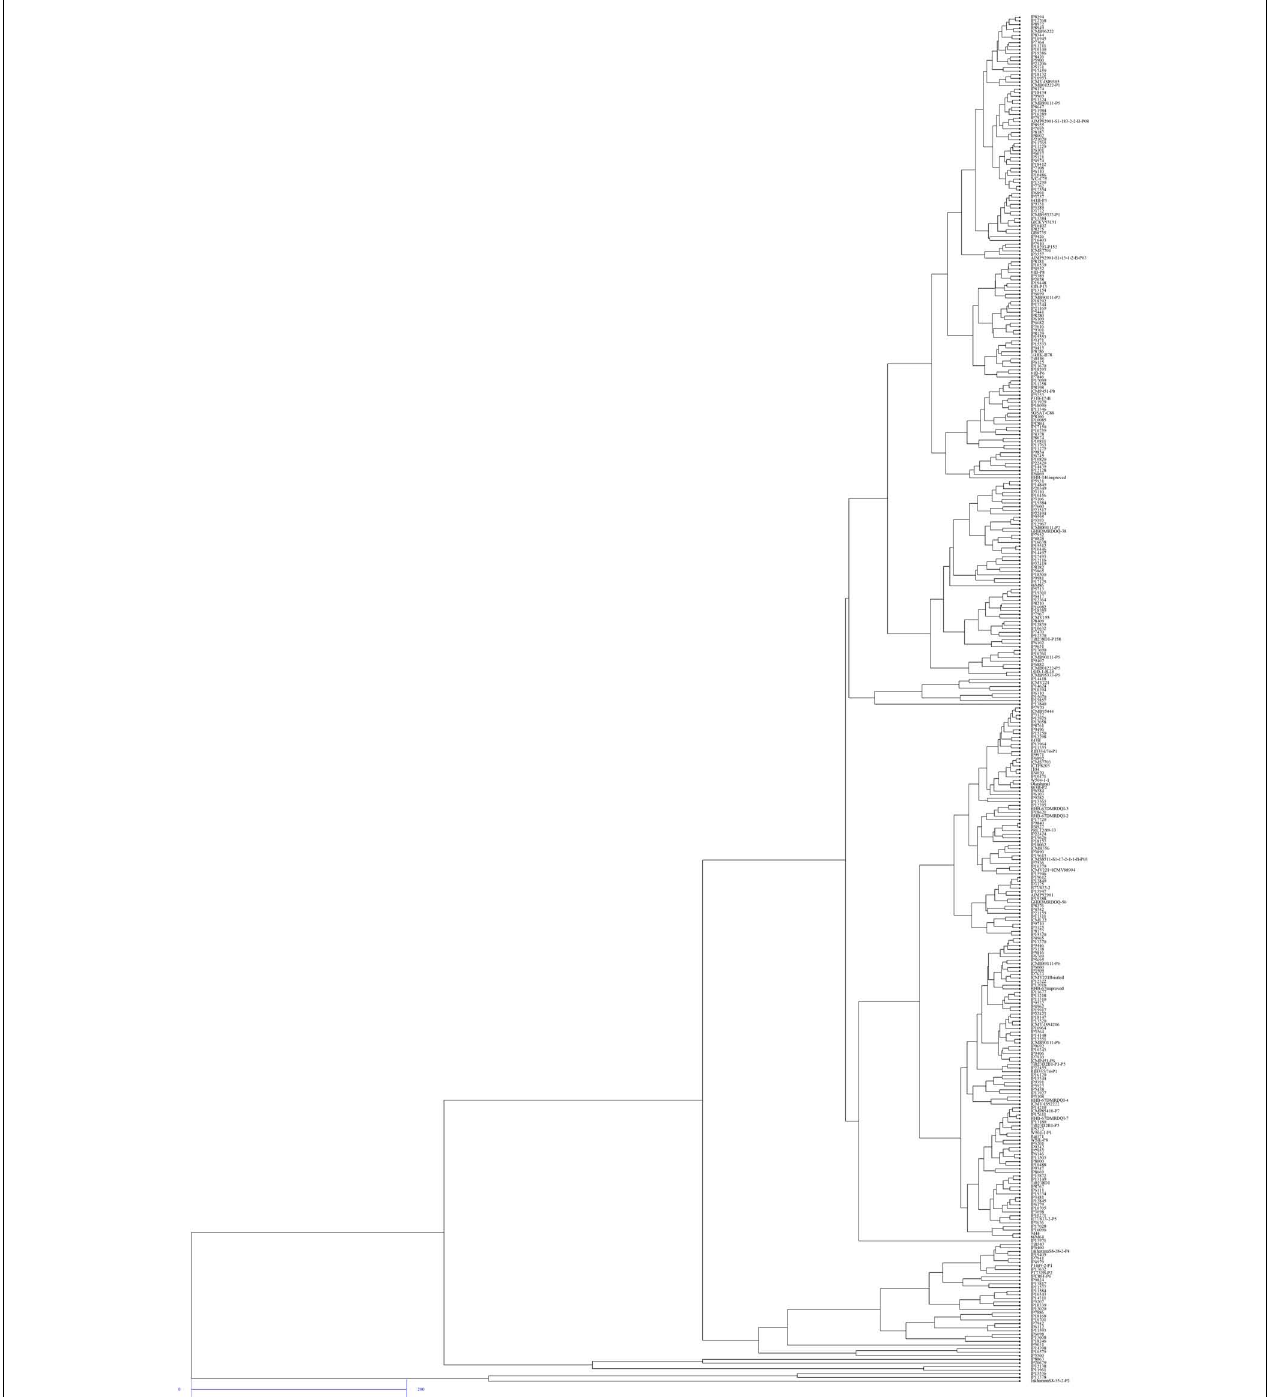
FIGURE 7 | Dendrogram of 380 pearl millet genotypes for five traits under low nitrogen conditions (N 0 ) by the UPGMA method.